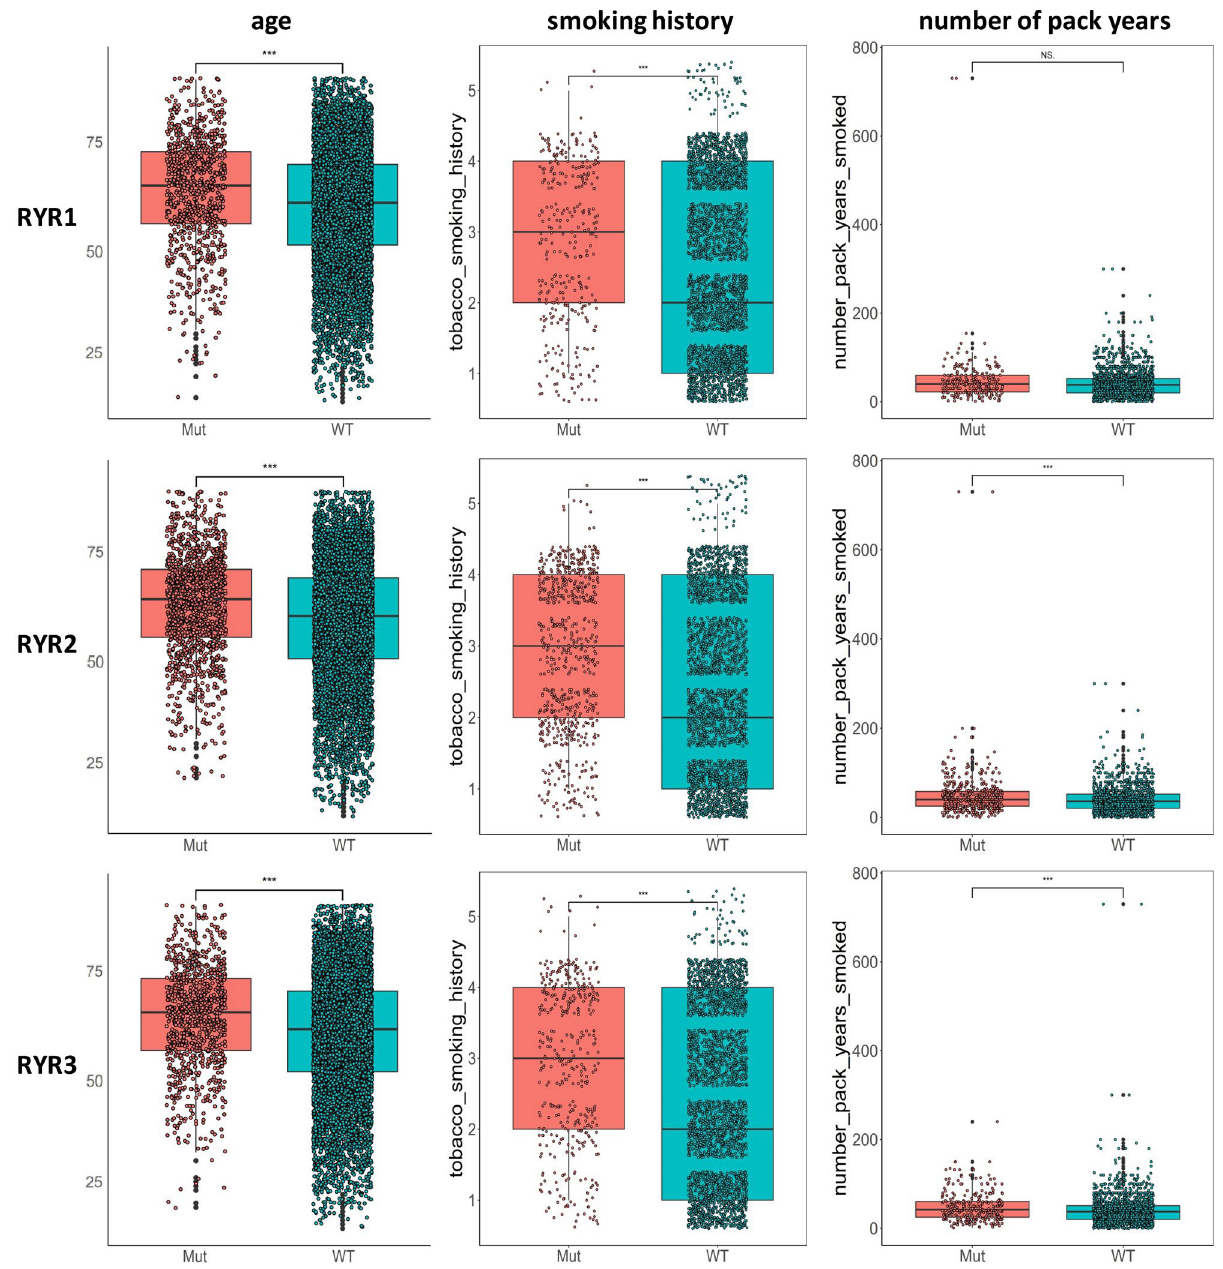
Figure 10. Comparison of age and smoking status between mutant and wild type RYR. Scatter plot of age, smoking history grading and number of cigarette pack years status grouped by RYR1, RYR2 and RYR3 mutational status is shown, as indicated. *P < 0.05; **P < 0.01; ***P < 0.001. Grading of smoking history: 1 = Lifelong Non-smoker (less than 100 cigarettes smoked in Lifetime); 2 = Current smoker (includes daily smokers and non-daily smokers or occasional smokers); 3 = Current reformed smoker for > 15 years (greater than 15 years); 4 = Current reformed smoker for ≤ 15 years (less than or equal to 15 years); 5 = Current reformed smoker, duration not